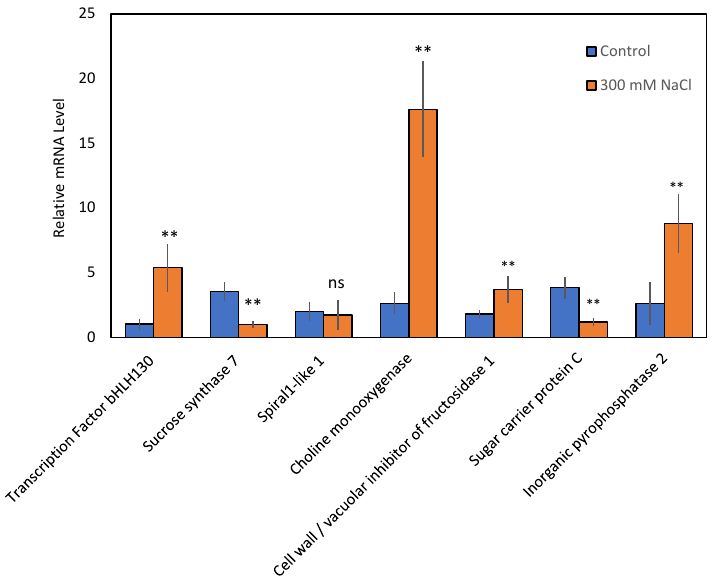
Figure 9. Transcript levels of genes encoding seven altered abundance proteins. Values are means of 3 biological and 3 technical measurements ± SE. Asterisk (*) denotes a significant mRNA difference between control and salt stress for each gene (Student’s t -test, p < 0.05).